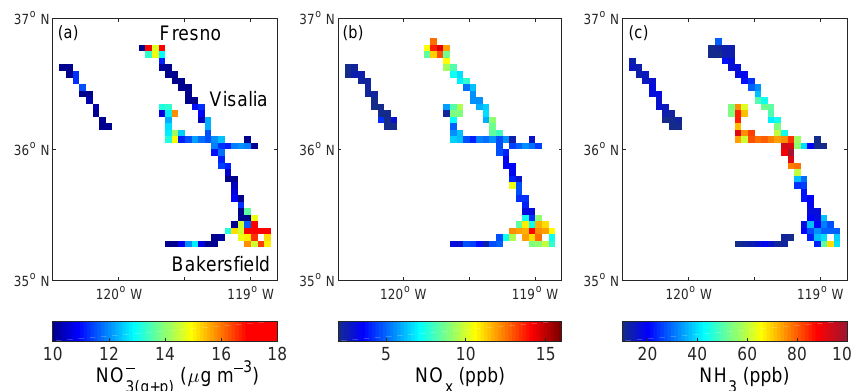
Figure 3. NO − (µgm − 3 ) in PM 2 . 5 (a) , NO x (ppb) (b) , and NH 3 (ppb) (c) measured onboard the NASA P-3B below the fully formed 3 ( g + p ) afternoon boundary layer and at pressure altitude (a.s.l.) greater than 0 on the same days and averaged to a 0.05 ◦ × 0.05 ◦